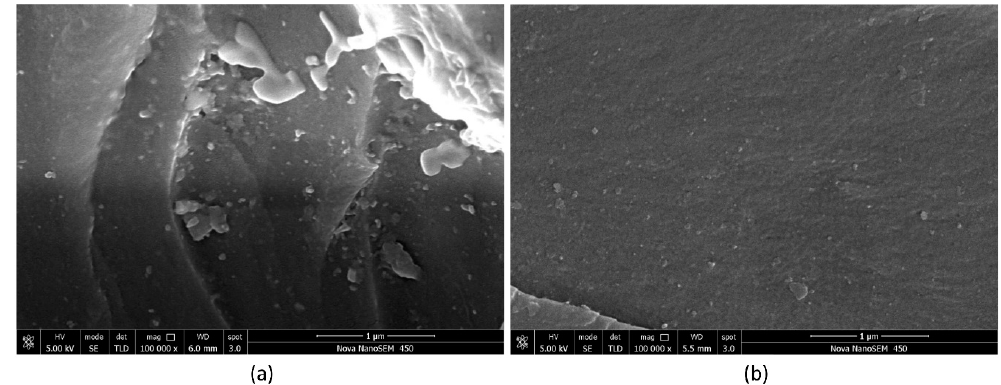
Figure 4. The fracture surfaces of samples of No. 3 (10–30, 20–30, 0.5) ( a ) and No. 5 (0.5–2, <8, 0.5) ( b ).